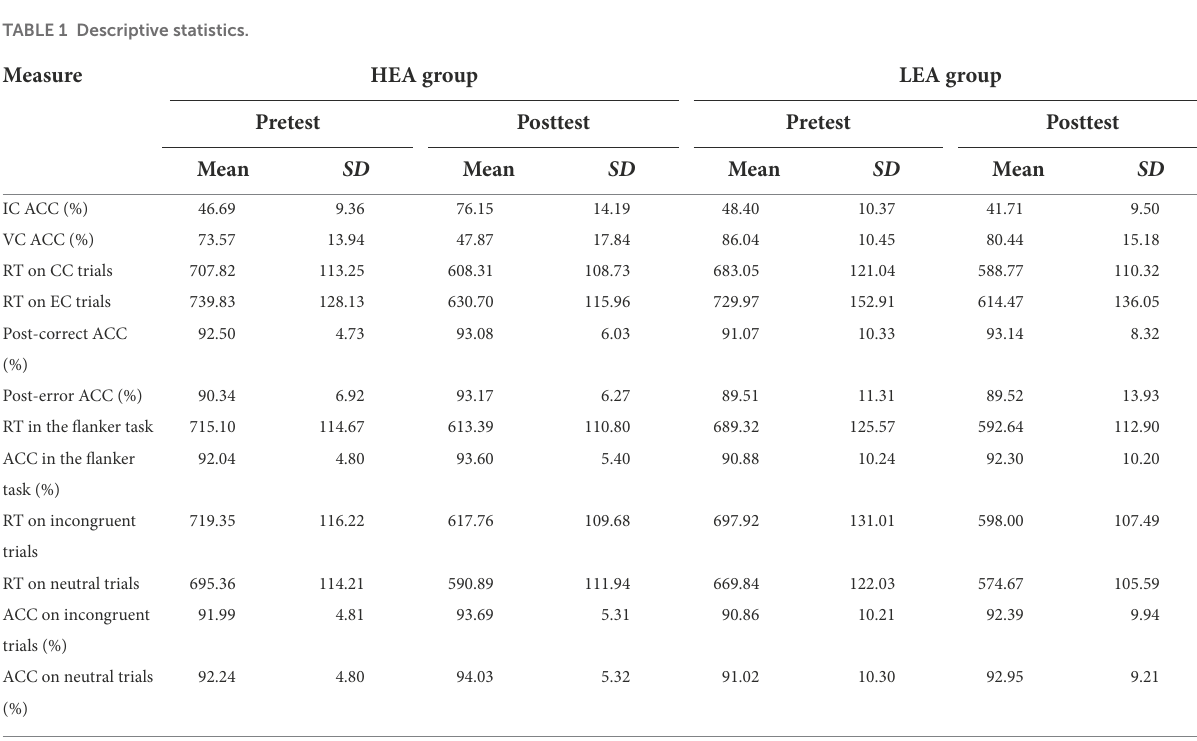
TABLE 1 Descriptive